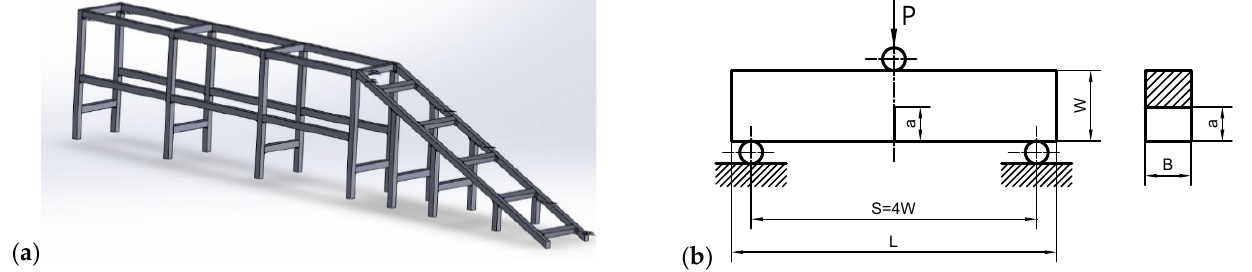
Figure 2. ( a ) Model of the fragment of inroad for cars that has been damaged and for which the research material is presented in [5,6]. ( b ) Geometry of the SEN(B) specimen, which was used in the fracture toughness tests [5,6]: W —specimen width (W = 25 mm), B —specimen thickness ( B = {5, 10, 15)} mm), a —crack length ( a / W = 0.50), S— support spacing, L —total length of the specimen ( L = 120 mm).